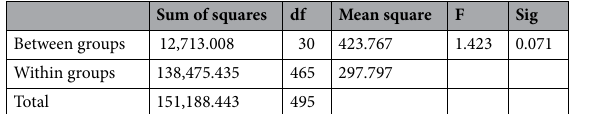
Sum of squares df